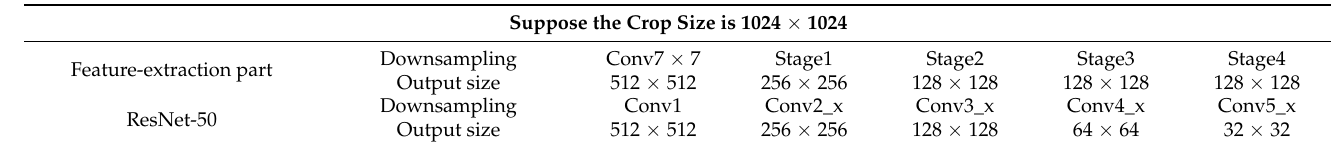
Table 4. Comparison of the output size of the feature map caused by the downsampling operation in the feature-extraction part of the proposed method and the original